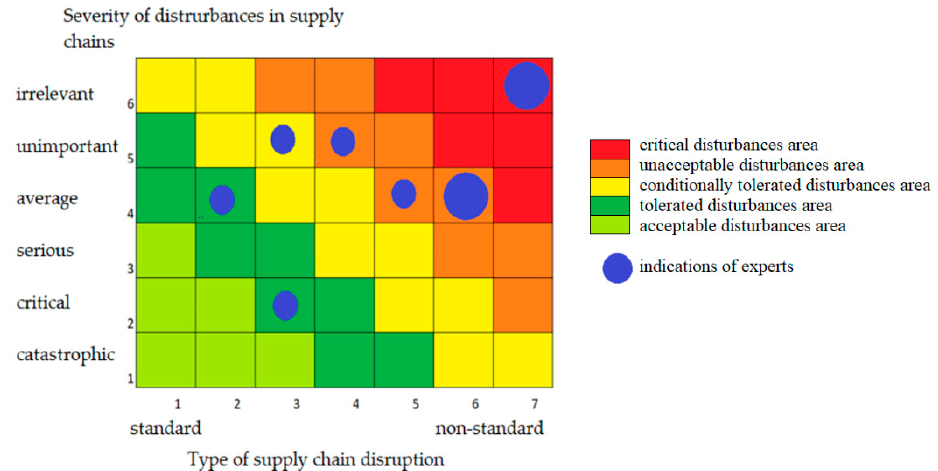
Figure 8. Impact of the type of disturbance on the severity of the disturbance in the supply chain.